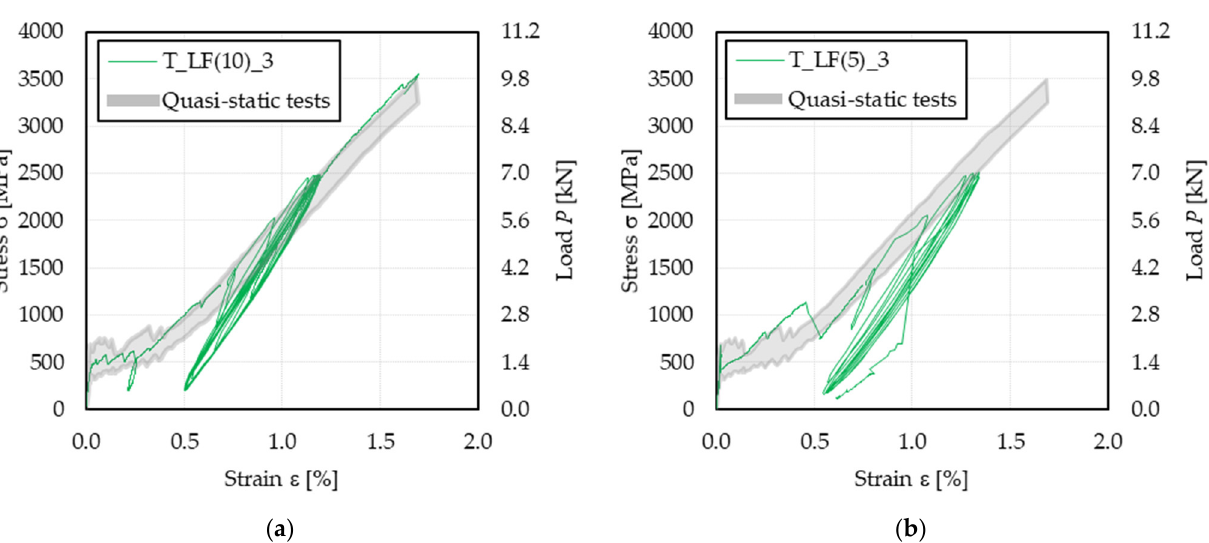
Figure 4. Stress (load)–strain curve of specimens subjected to low-cycle fatigue: ( a ) specimen T_LF(10)_3; ( b ) specimen T_LF(5)_3.